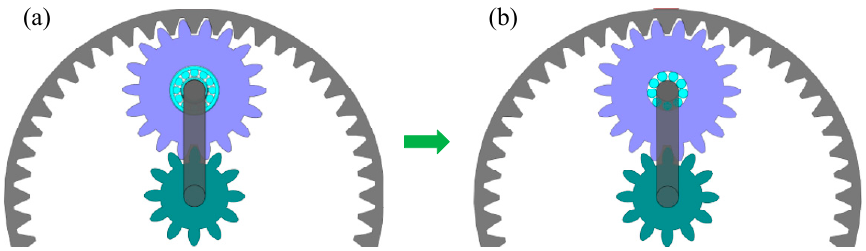
Figure 20. Comparison of planet bearings: ( a ) original bearing; ( b ) improved bearing.